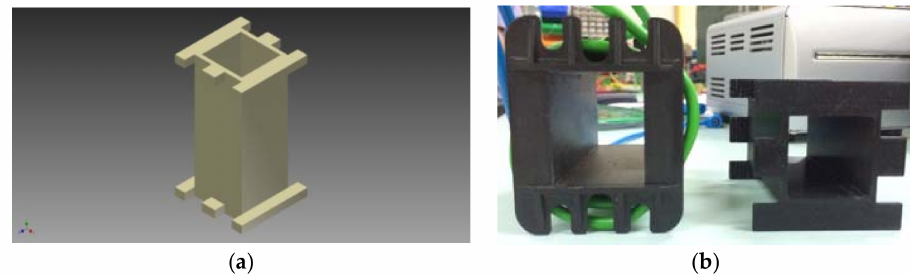
Figure 5. 3D printing technology: ( a ) configuration for 3D printing; and ( b ) comparison of a commercial and a 3D printed bobbin.